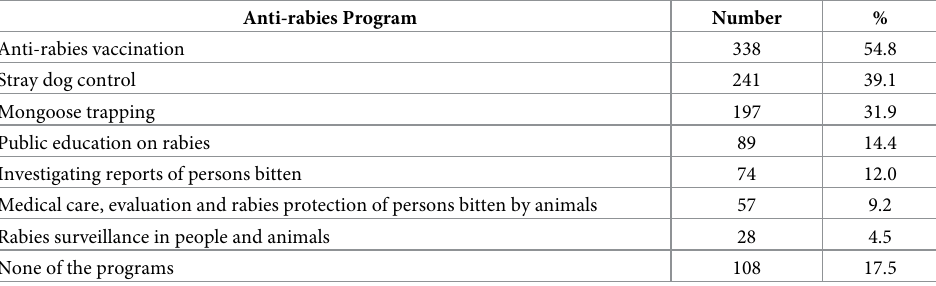
Table 4. Awareness of the Ministry of Health’s anti-rabies programs.